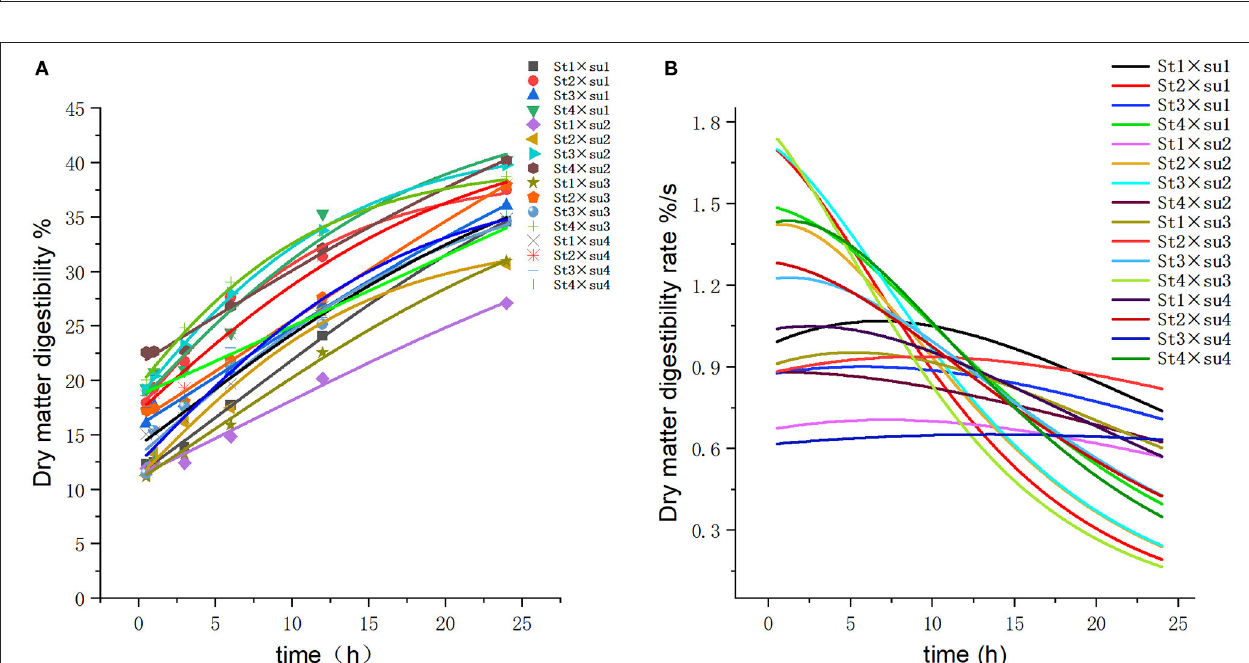
FIGURE 2 | Fitting model curve of DM digestibility. (A) Gompertz model fitting curve. (B) Derivative of Gompertz.